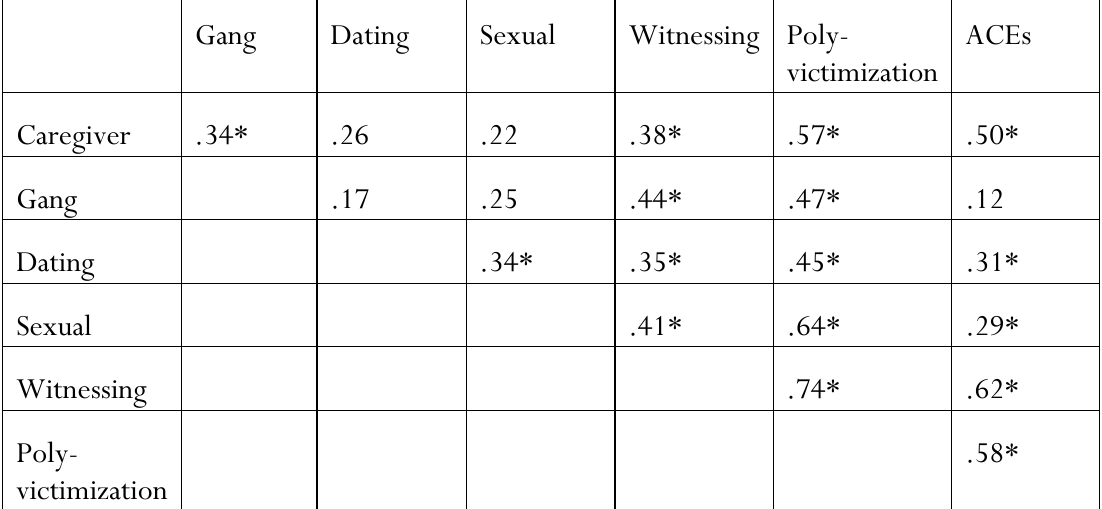
Table 4: Pearson Correlations among Victimization Categories and Adverse Events Gang